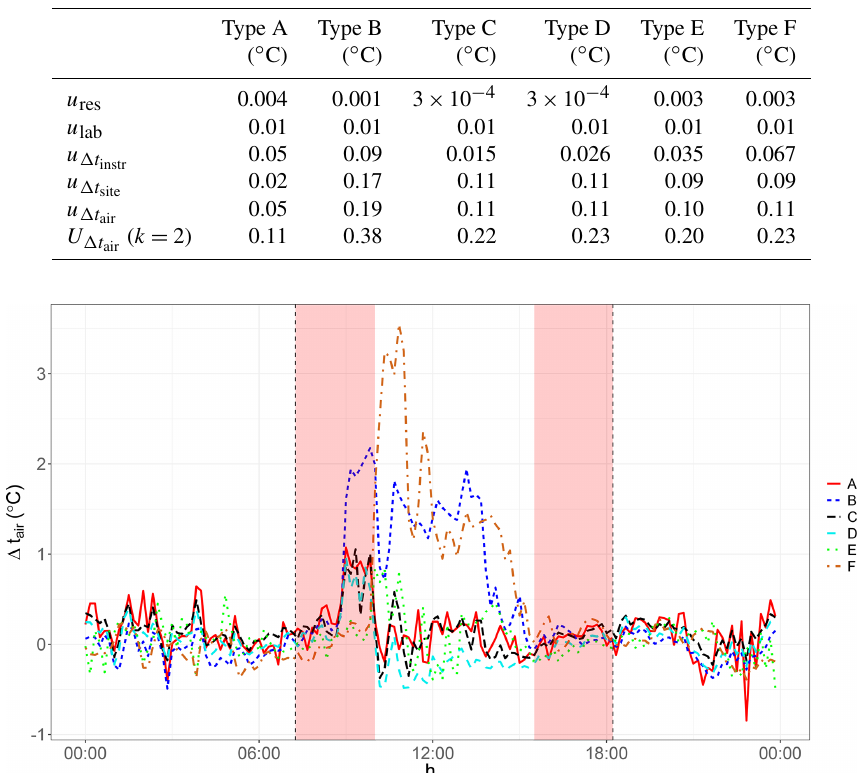
Figure 6. A typical plot of a 1d long acquisition (25 February 2017), showing the effect in terms of temperature differences (cid:49)t air (defined in the text as Eq. 1) among pairs of identical sensors (reported in the legend shown in Fig. 4b and with the properties stated in Table 1). This day has been selected as a representative example, with snow having been removed a few days before. The weather was mainly sunny, with a maximum incident radiation of 700Wm − 2 , a maximum reflected radiation of 500Wm − 2 in snow conditions and less than 100Wm − 2 in the snow-free area. Vertical dashed lines represent the sunset and sunrise times, while shaded areas mark the periods when incident radiation on the sensors was < 300Wm − 2 (no or faint direct sunlight). Hours are reported in local time (central European time –